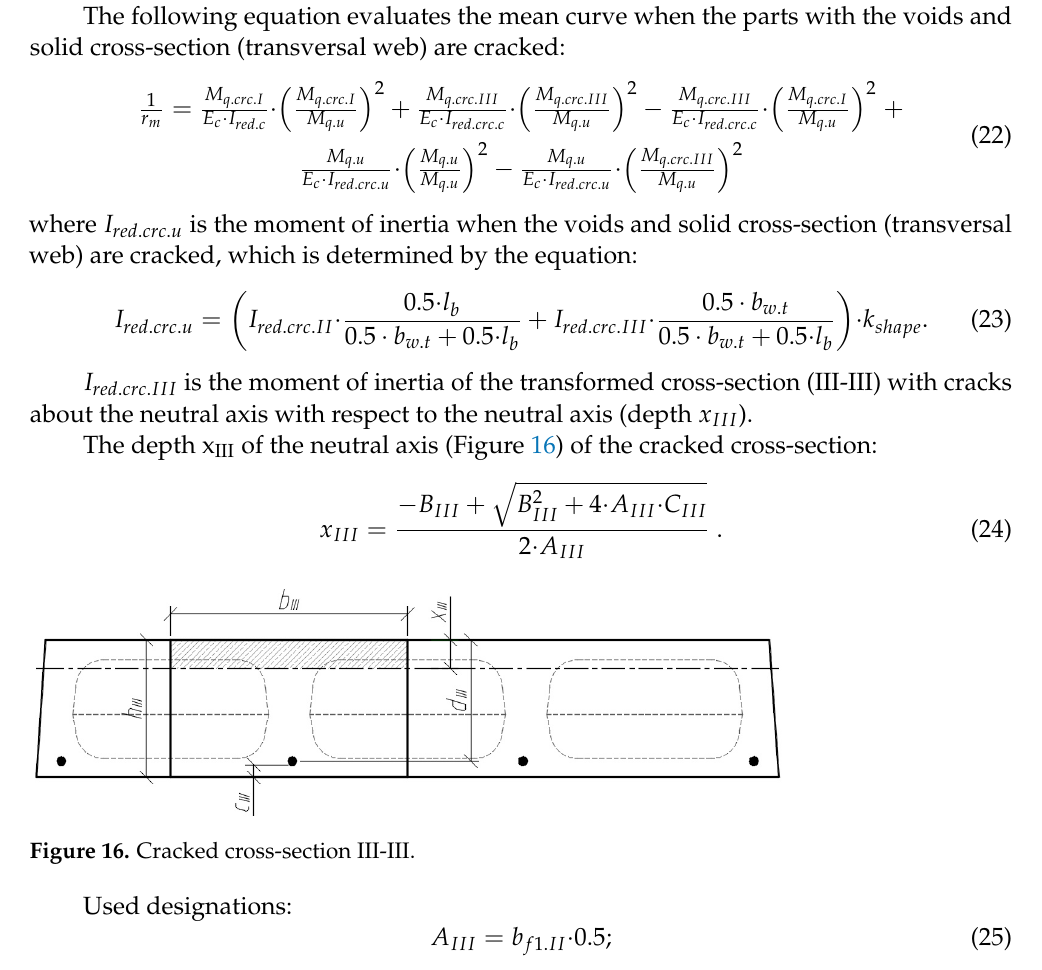
13 of 20 Figure 15. Cracked cross-section II-II, when 𝑥 (cid:3010)(cid:3010) ≤ ℎ (cid:3033)(cid:2869).(cid:3010)(cid:3010) . The cracking moment in section III-III can be calculated by the equation: 𝑀 (cid:3044).(cid:3030)(cid:3045)(cid:3030).(cid:3010)(cid:3010)(cid:3010) = 𝑓 (cid:3030)(cid:3047) 𝐼 (cid:3045)(cid:3032)(cid:3031).(cid:3010)(cid:3010)(cid:3010) 𝑦 (cid:3030).(cid:3010)(cid:3010)(cid:3010) + 𝑃 (cid:3040) (cid:4666)𝑒 (cid:3010)(cid:3010)(cid:3010) + 𝑟 (cid:3010)(cid:3010)(cid:3010) ). (20) Deflection of the slab when the slab is cracked at the parts with the voids and in the solid cross-section parts (transversal webs): 𝜔 (cid:3046).(cid:3044).(cid:3030)(cid:3045).(cid:3010)(cid:3010)(cid:3010) = 𝑘 ∙ 1 𝑟 (cid:3040) ∙ 𝑙 (cid:3046)(cid:2870) .